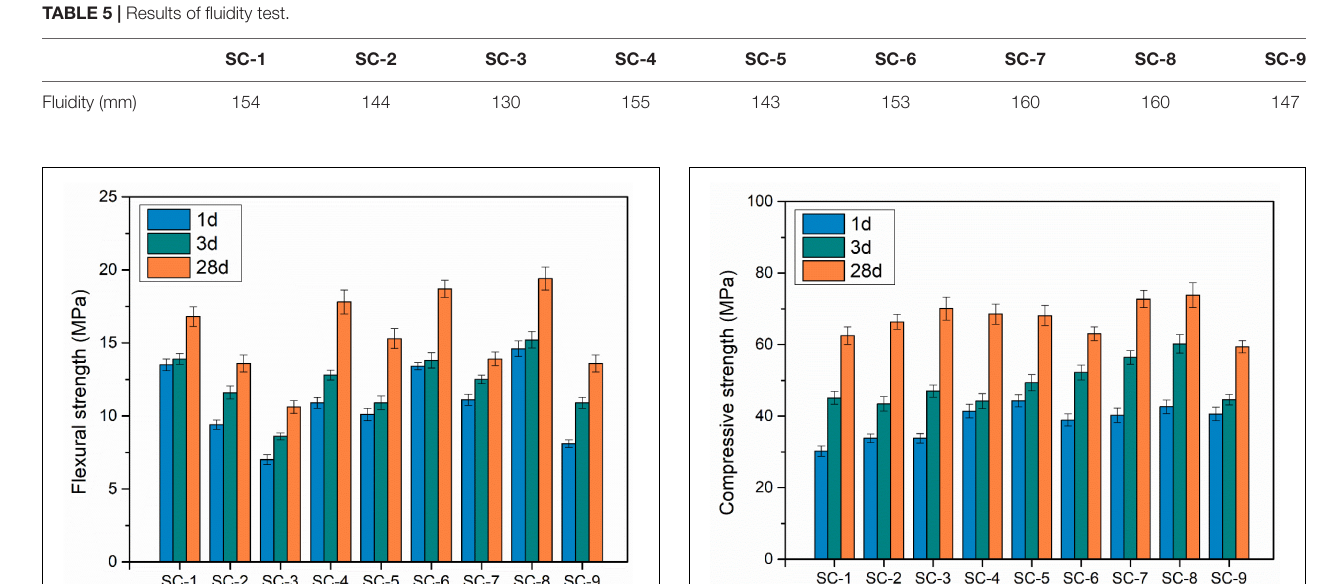
TABLE 5 | Results of fluidity test.